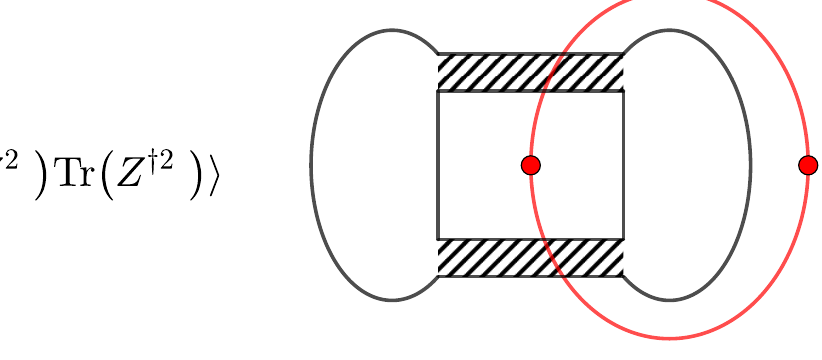
Figure 3 . The original ribbon graph is in black. The (cid:26) graph is in